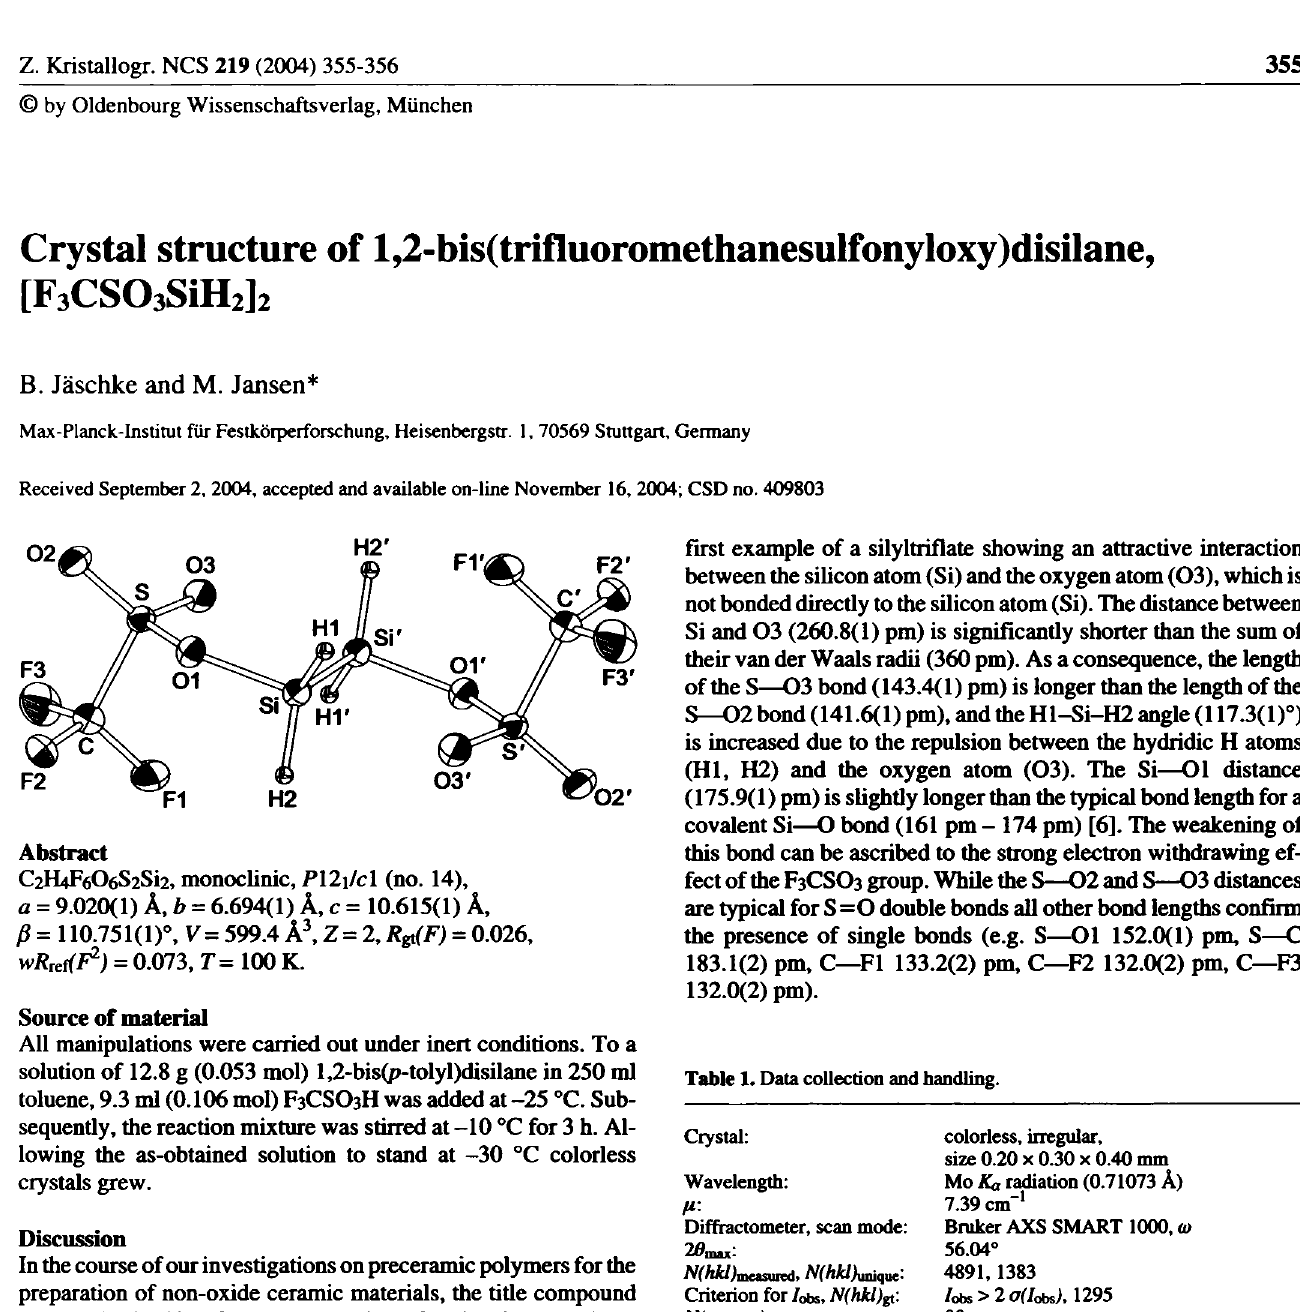
Table 2. Atomic coordinates and displacement parameters (in Â 2